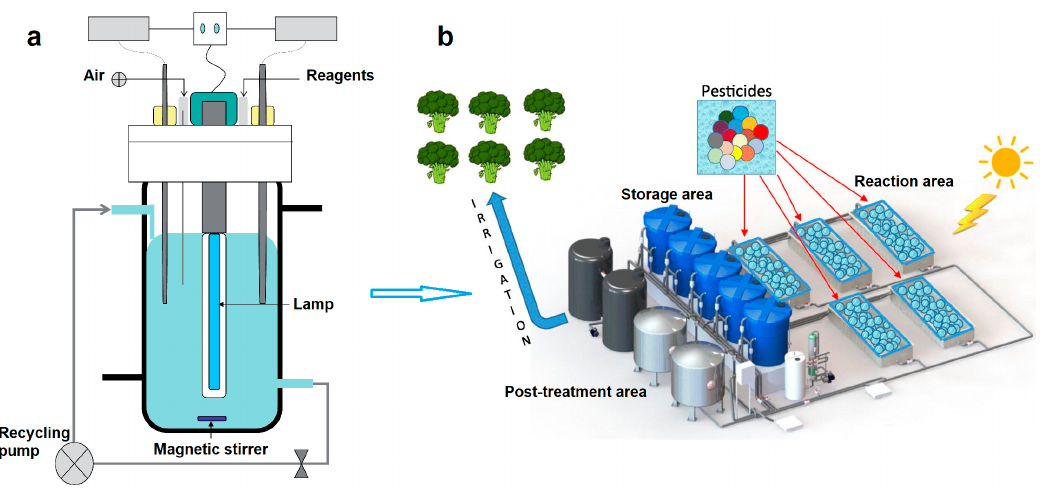
Figure 7. Reclamation of agro-wastewater polluted with pesticides: ( a ) Schematic drawing of the laboratory photochemical reactor [125], and ( b ) Scheme for the pilot-plant [126].